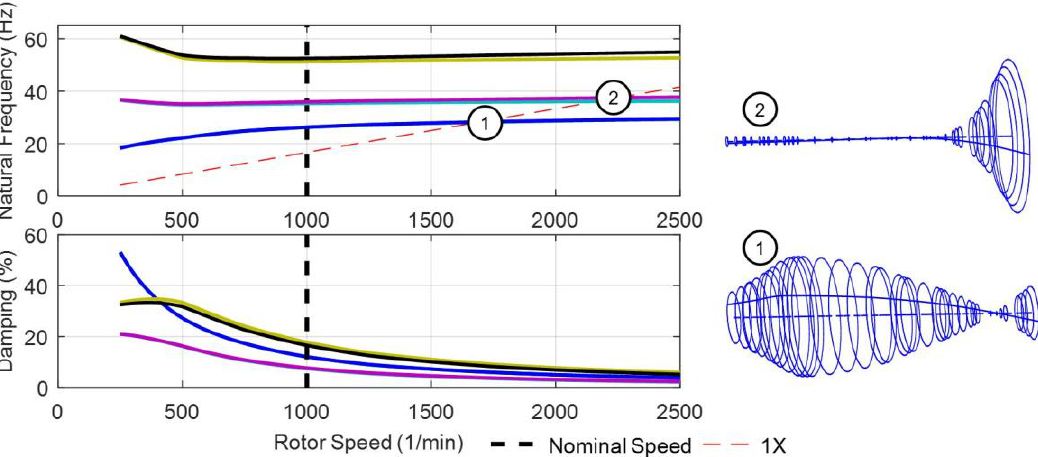
Figure 10. Campbell diagram of the rotor using bearing stiffness and damping of the bearing center; shape forms of the natural frequencies of the first and second critical speed, variant 1.